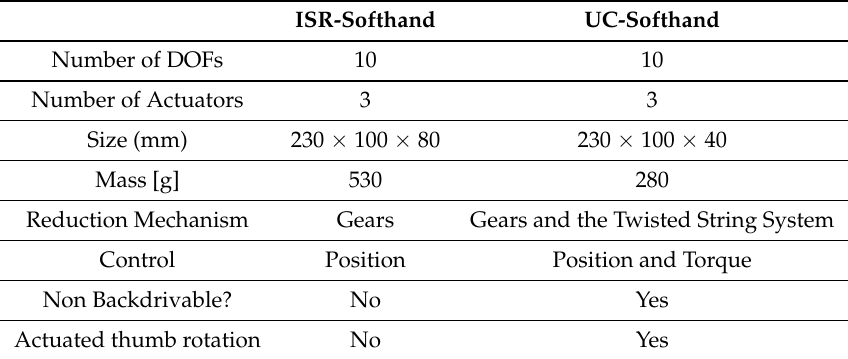
Table 1. Characteristics of the ISR-Softhand and the